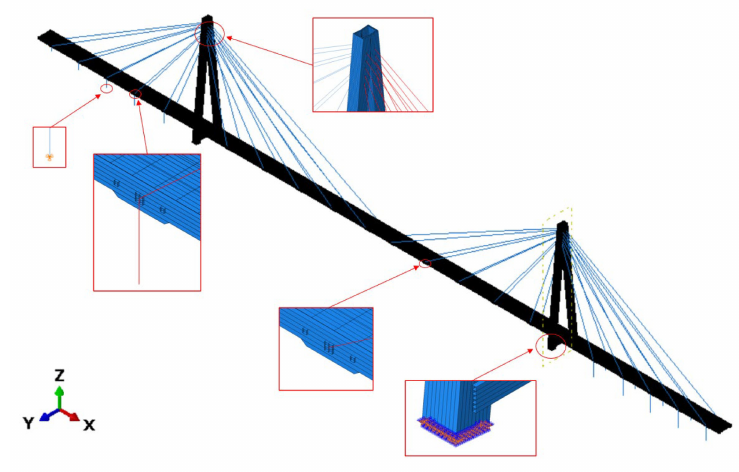
Figure 8. The FE model of the cable-stayed composite material footbridge.